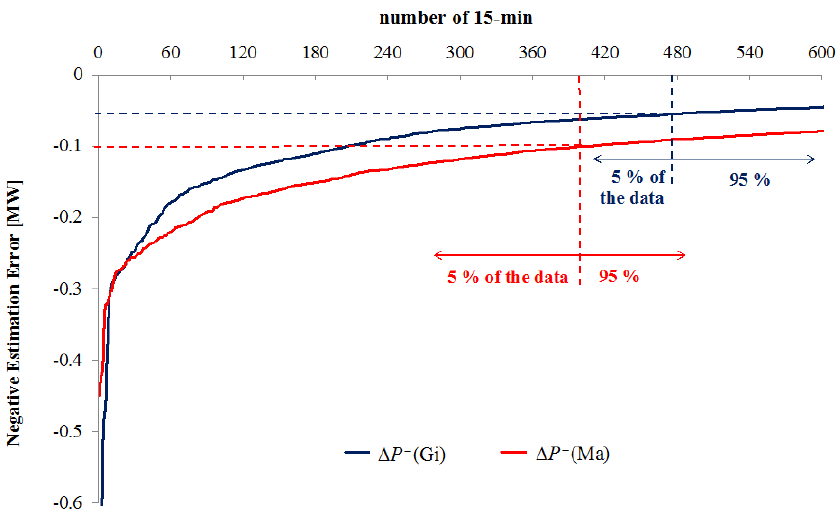
Figure 15. Zoom of the duration curves of negative estimation errors of the AC power profiles with respect to experimental results for the year 2012 at the sites “Gi” and “Ma”.